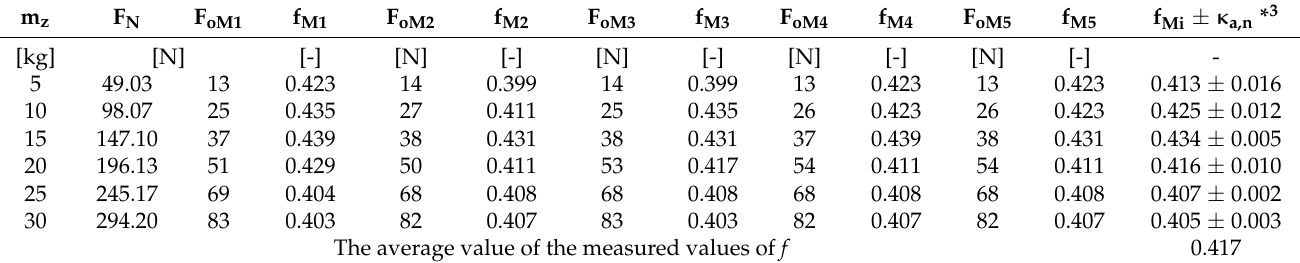
Table 4. Friction coefficient, dry groove, 8 mm diameter